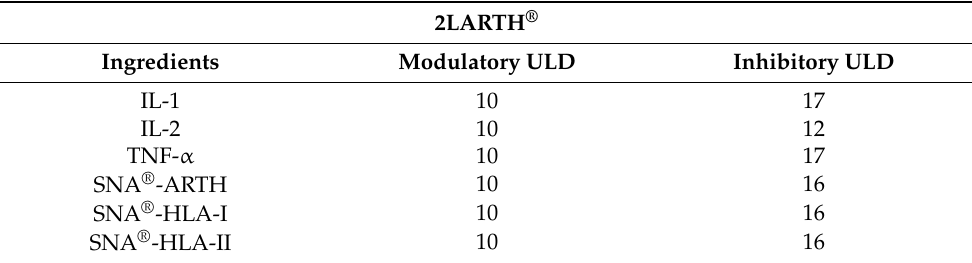
Table 2. Table summarizing the 2LARTH ® formulation and dilutions employed in the different capsules. The dilutions of each cytokine/factor/SNA ® at ULD are indicated in CH (Centesimal Hahnemannian). MI medicines are based on the principle that a given immune regulator exerts either stimulatory effects when used at LD or displays modulatory/inhibitory features when prepared at ULD. ULD aim at modulating (from 8 to 12 CH) and lowering (higher than 12 CH) the expression of protein with upregulated levels. HLA: Human Leukocyte Antigen; IL: Interleukin; SNA ® : Specific Nucleic Acid; TNF- α : Tumor Necrosis Factor- α ; ULD: Ultra-Low Dose. 2LARTH ®